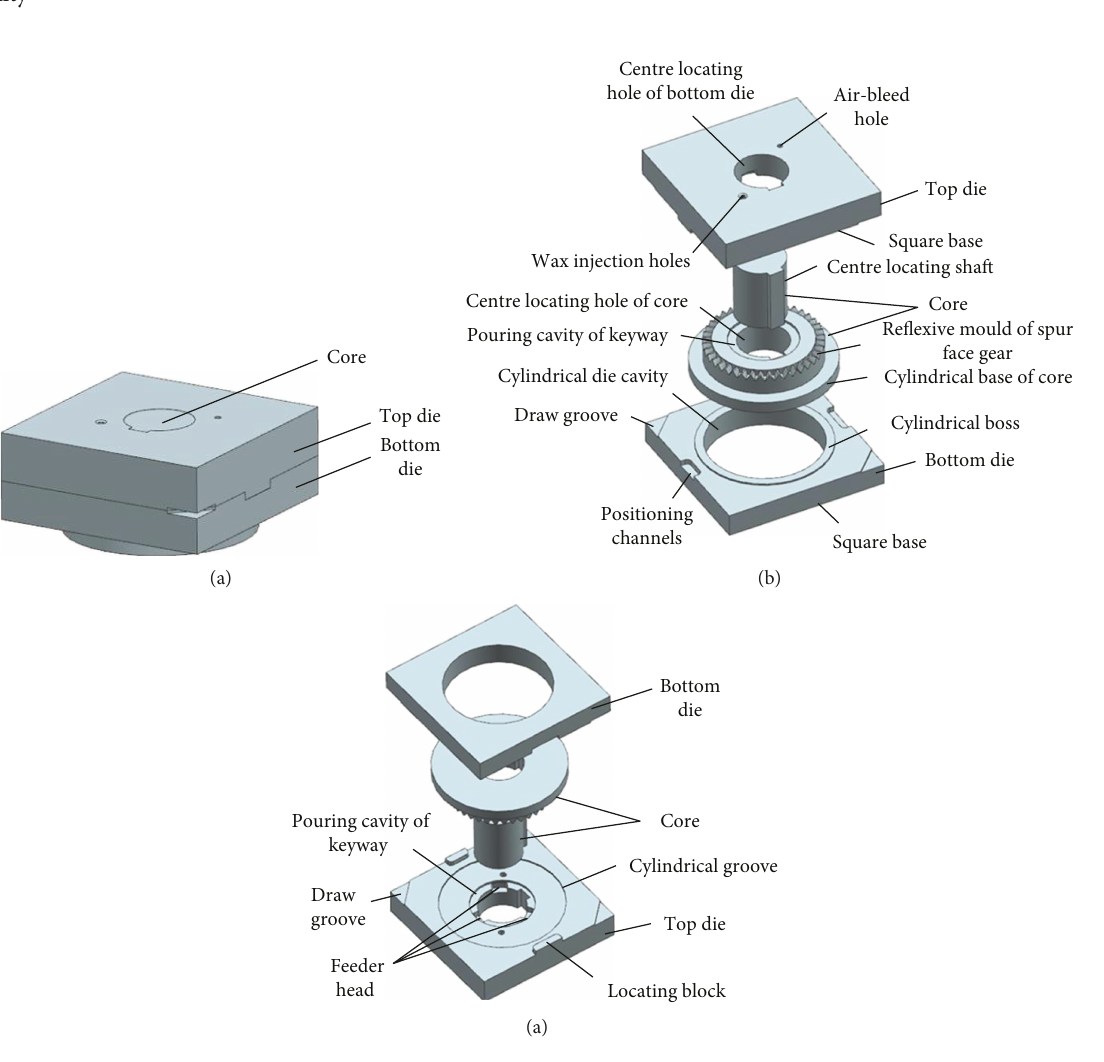
Figure 2: Sketch of the spur face gear master mould. Table 1: The performance parameters of ABS